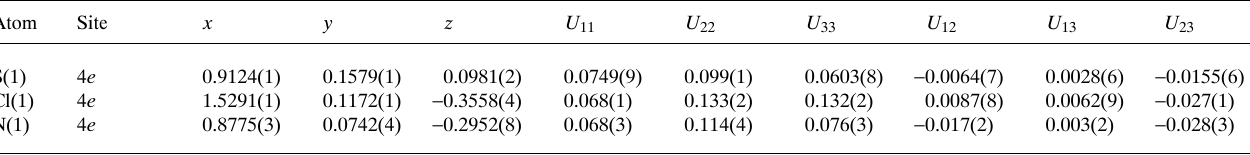
Table 3. A tomic coordin a tes a nd displ a cement p a r a meters (in Å 2 )